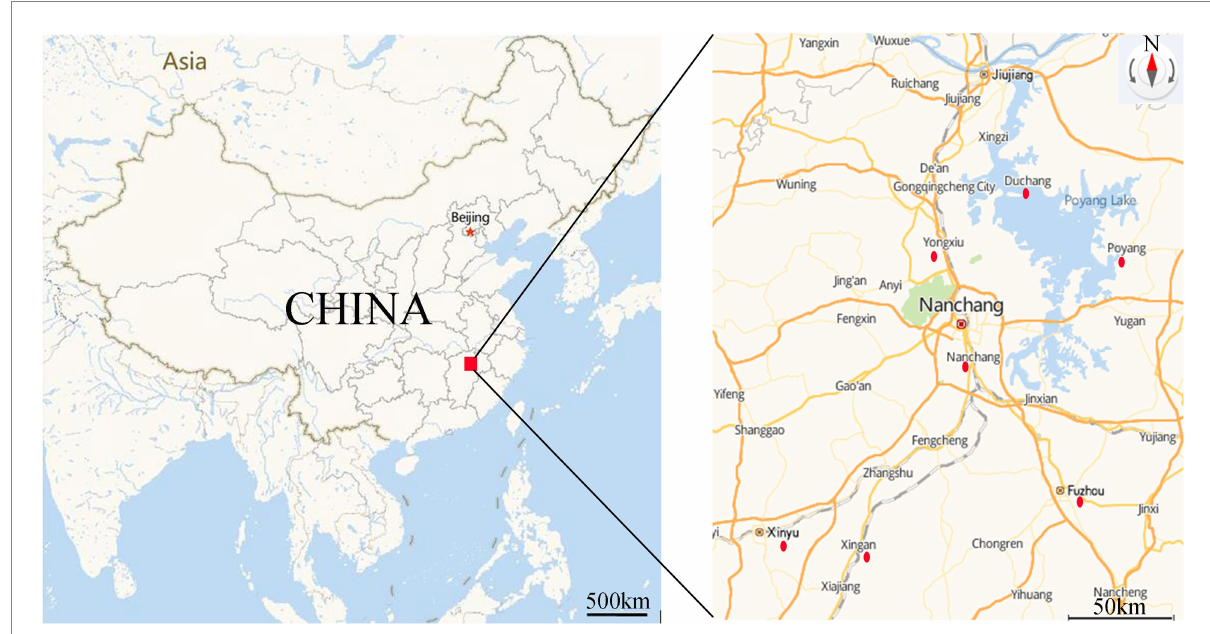
FIGURE 1 Sampling area and location of sampling sites. Red dot indicated the sampling sites. (https://lbs.amap.com/demo/javascript-api/example/map/